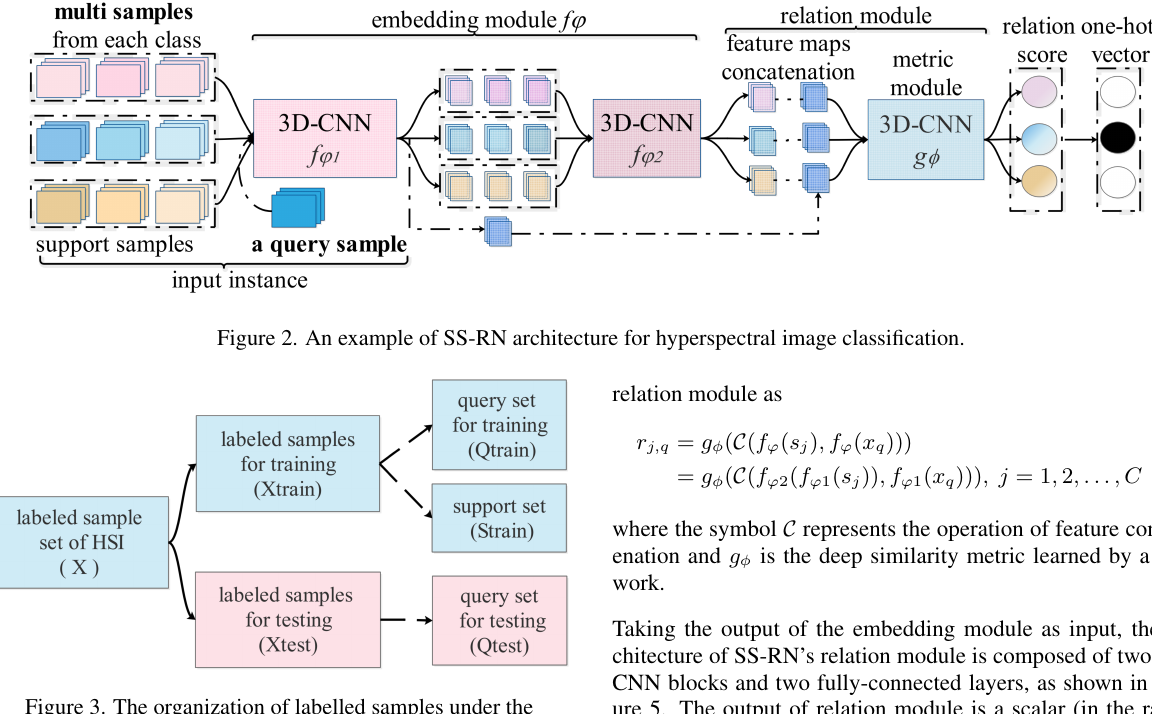
Figure 3. The organization of labelled samples under the framework of